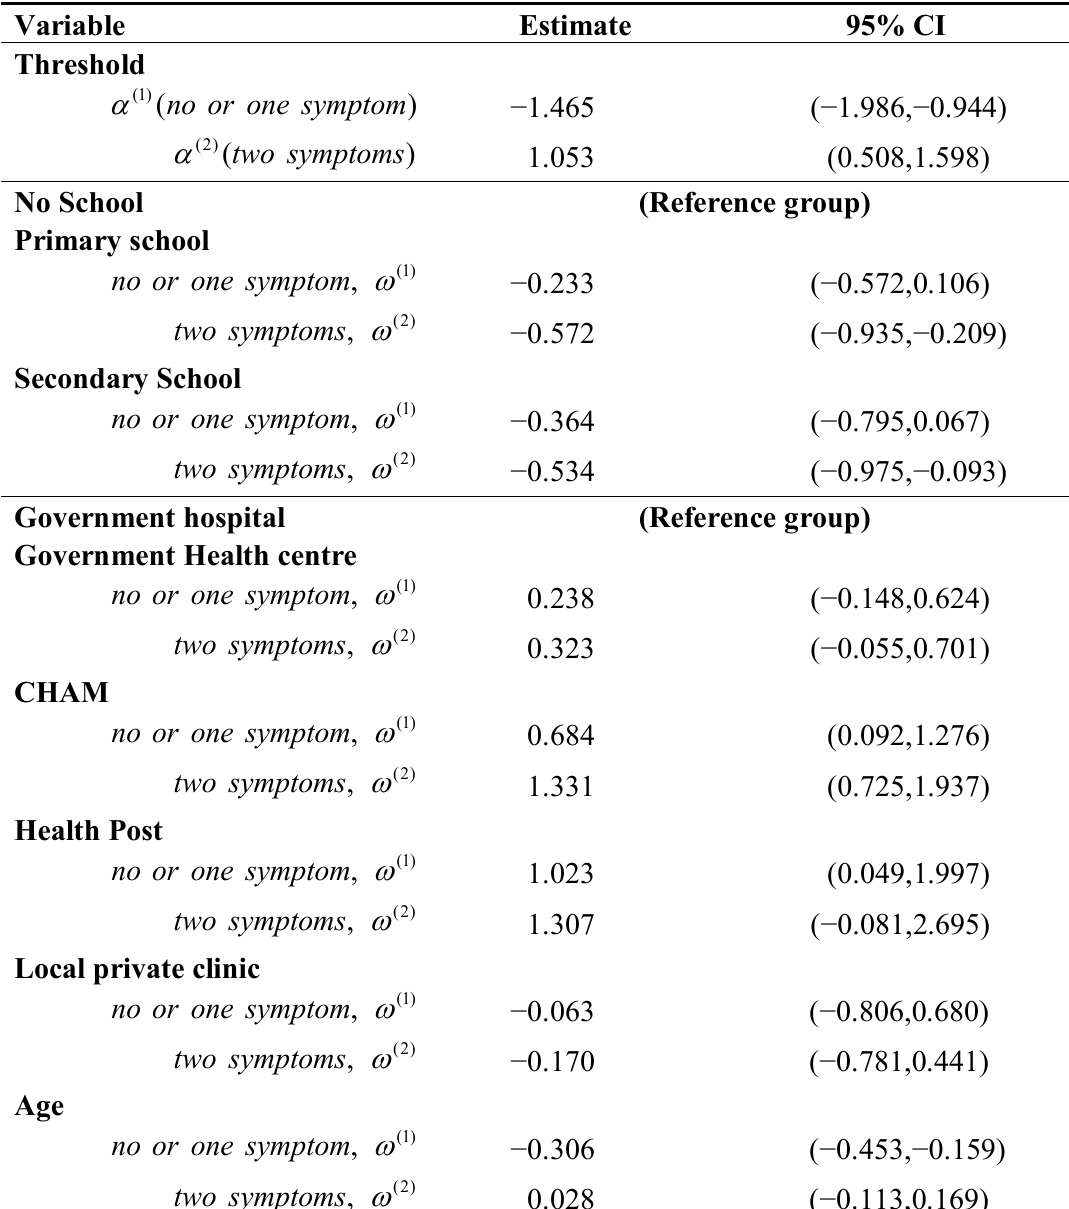
Table 3. Partial proportional odds models to identify determinants of responsible mothers’ knowledge on diarrhoea